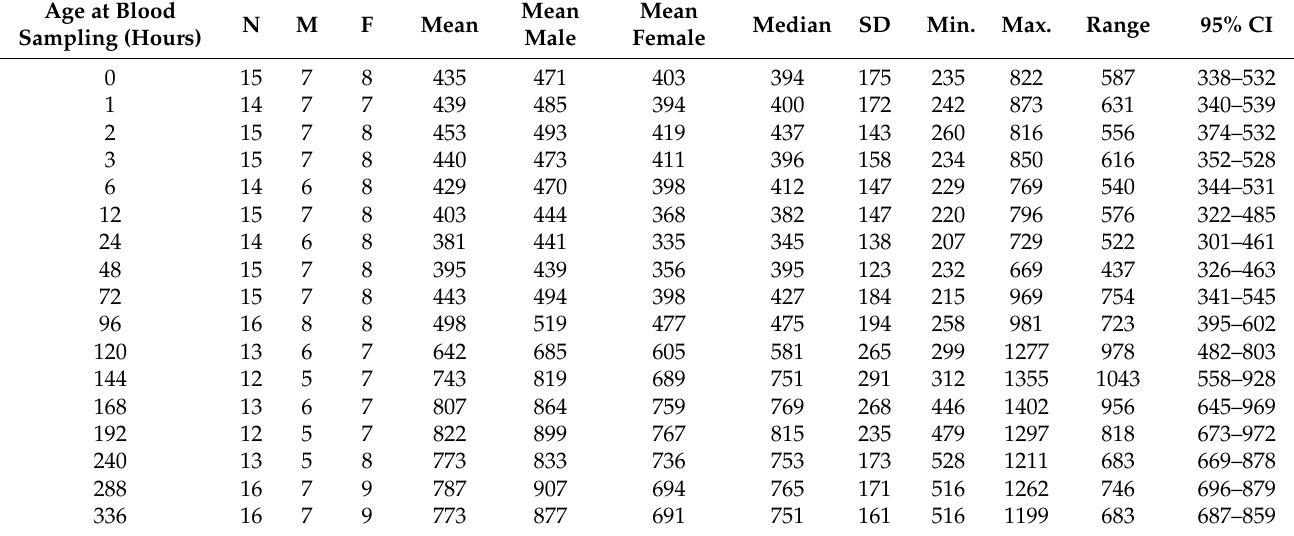
Table 2. Descriptive results of 243 platelet counts ( × 10 9 /L) from calves in the longitudinal study. N = amount of calves, M = amount of male calves, F = amount of female calves, SD = standard deviation, Min. = minimum, Max. = maximum, CI = confidence